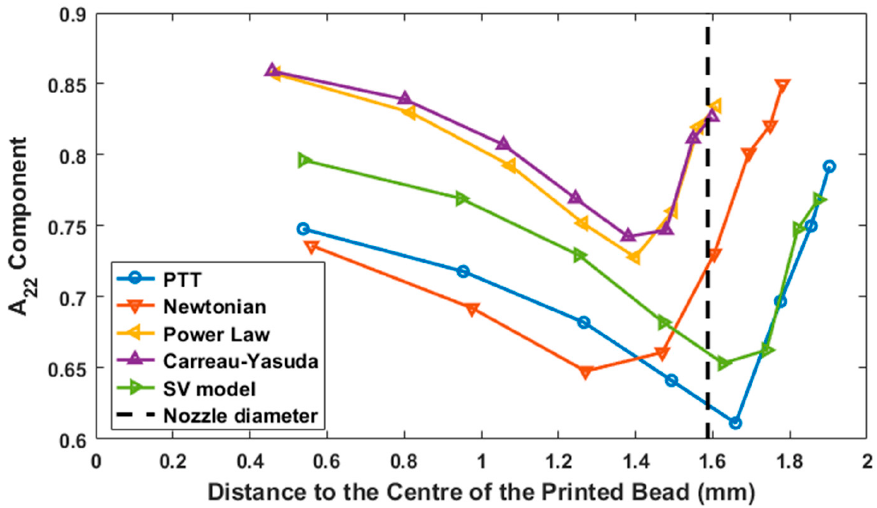
Figure 10. A (cid:2870)(cid:2870) component at the flow domain exit solved using employed rheology models. Figure 10. A 22 component at the flow domain exit solved using employed rheology